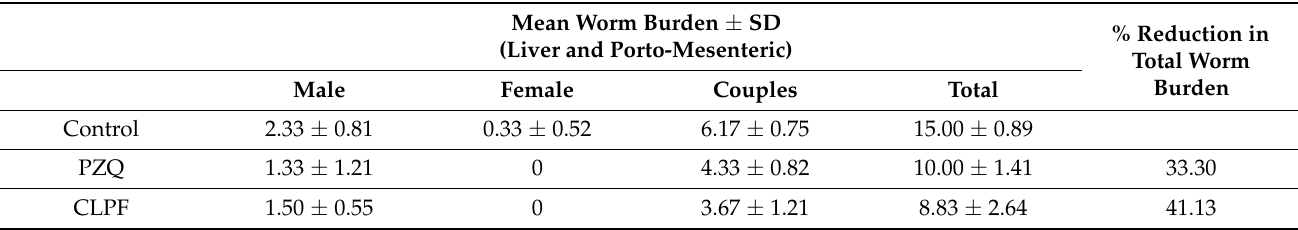
Table 3. Effect of PZQ and CLPF (single dose 250 mg/kg two weeks post-infection) on worm loadand their sex in S. mansoni -infected mice euthanized six weeks post-infection.